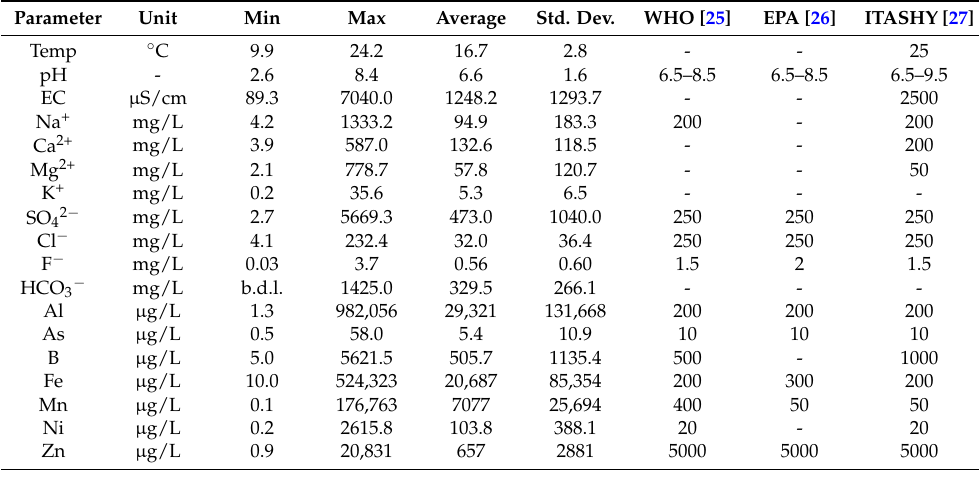
Table 1. General summary of the quality of water resources in the study